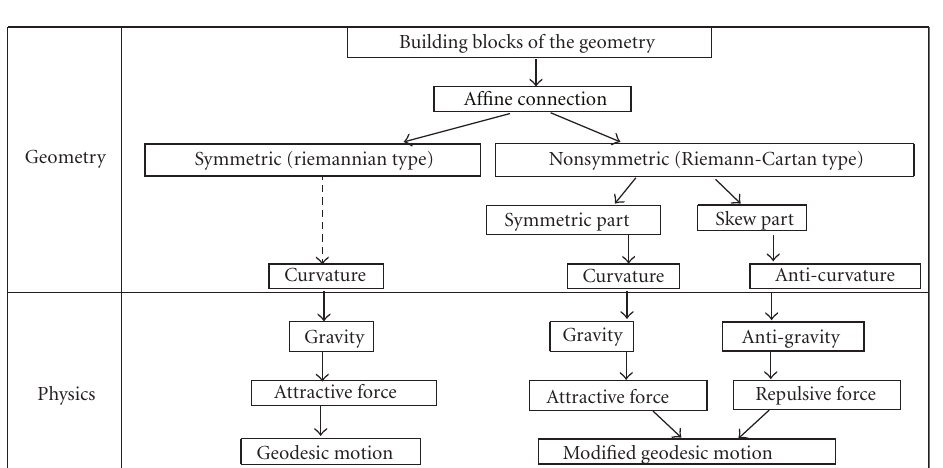
Figure 2: Geometrization of physics using geometries of Riemann and of Riemann-Cartan